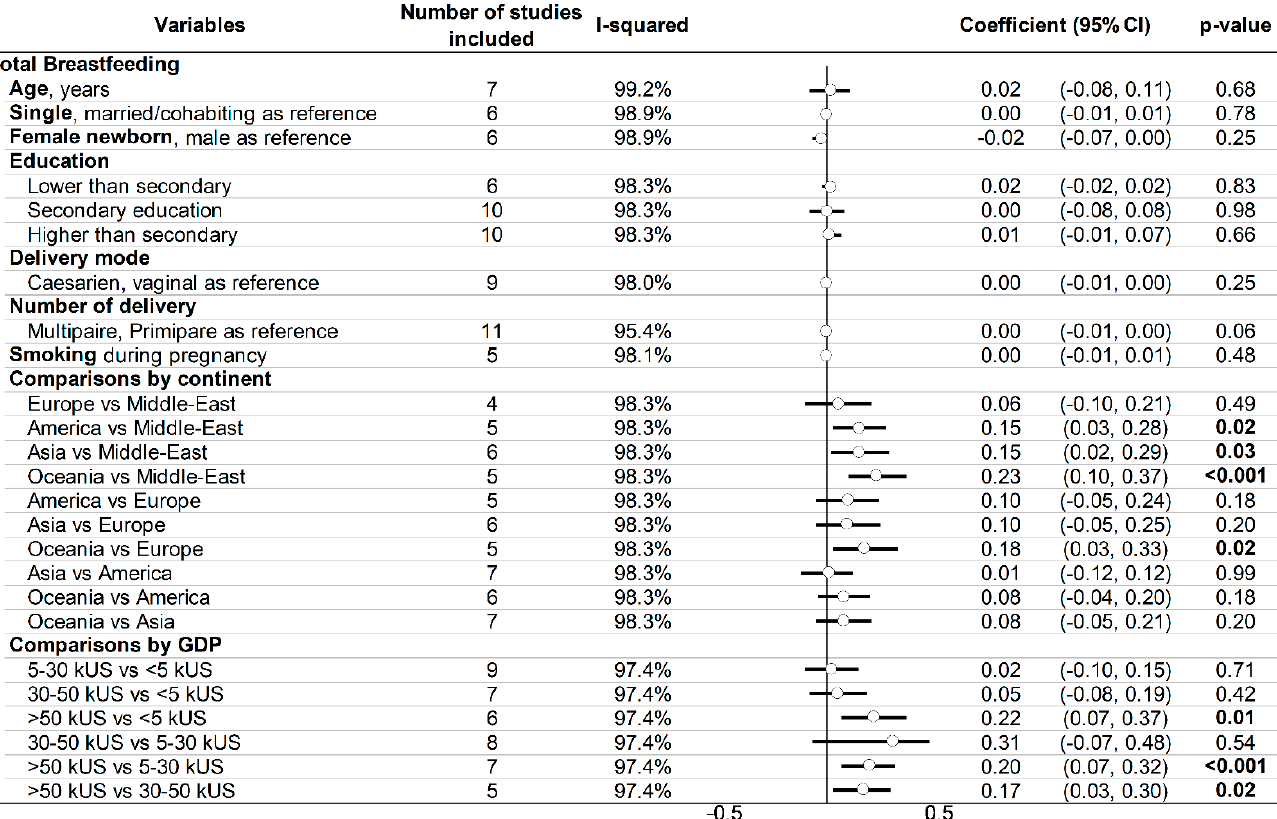
Figure 4. Meta-regression. Figure 4.